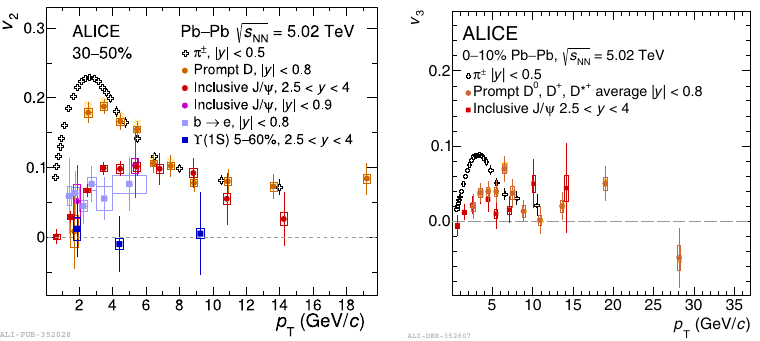
Figure 1. Left: Fraction of beauty-hadron decay electrons to heavy-flavor hadron decay electrons in pp collisions at √ s = 5.02TeV. Right: Beauty production cross section per unit of rapidity at midrapidity as a function of √ s measured in pp and p¯p collisions by di ff erent experiments [4]. Figure 3. Anisotropic flow coe ffi cient measurements as a function of p T in Pb–Pb collisions at √ s NN = 5 . 02TeV. Left: v 2 in 30–50% central collisions. Right: v 3 in 0–10% central collisions.